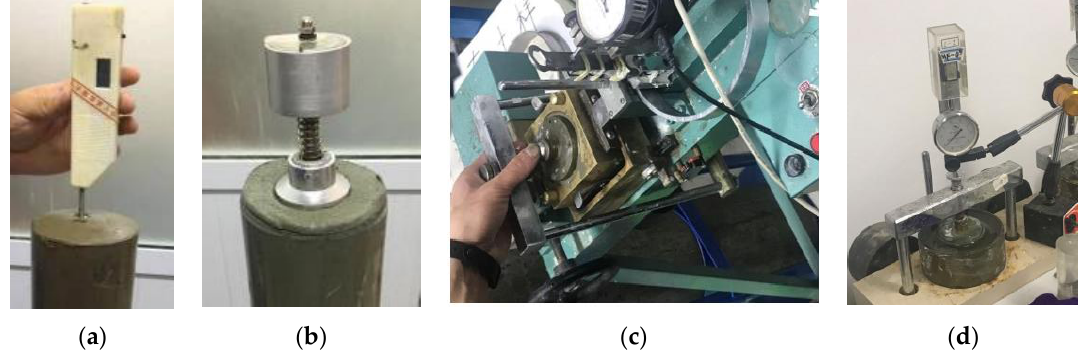
Figure 5. Laboratory test photos: ( a ) penetration resistance, ( b ) shear strength, ( c ) direct shear tests, ( d ) consolidation test. ( d ) consolidation test.